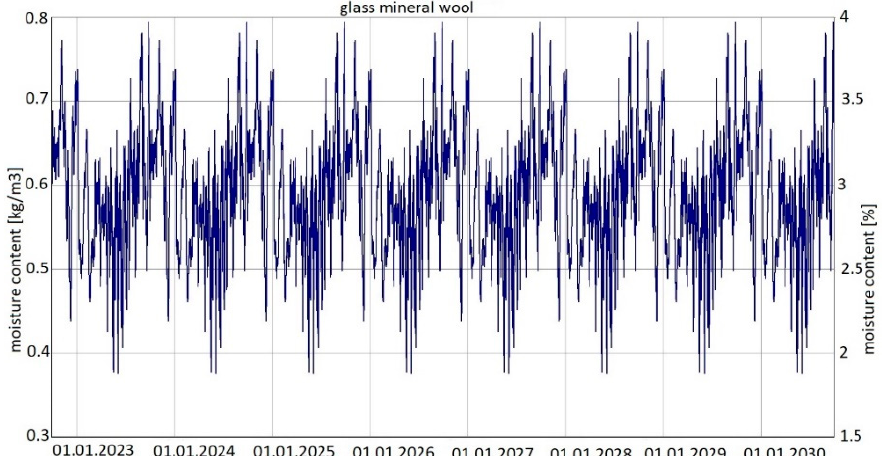
Figure 9. Changes in moisture content in glass mineral wool over eight years, variants 1–3 [70].